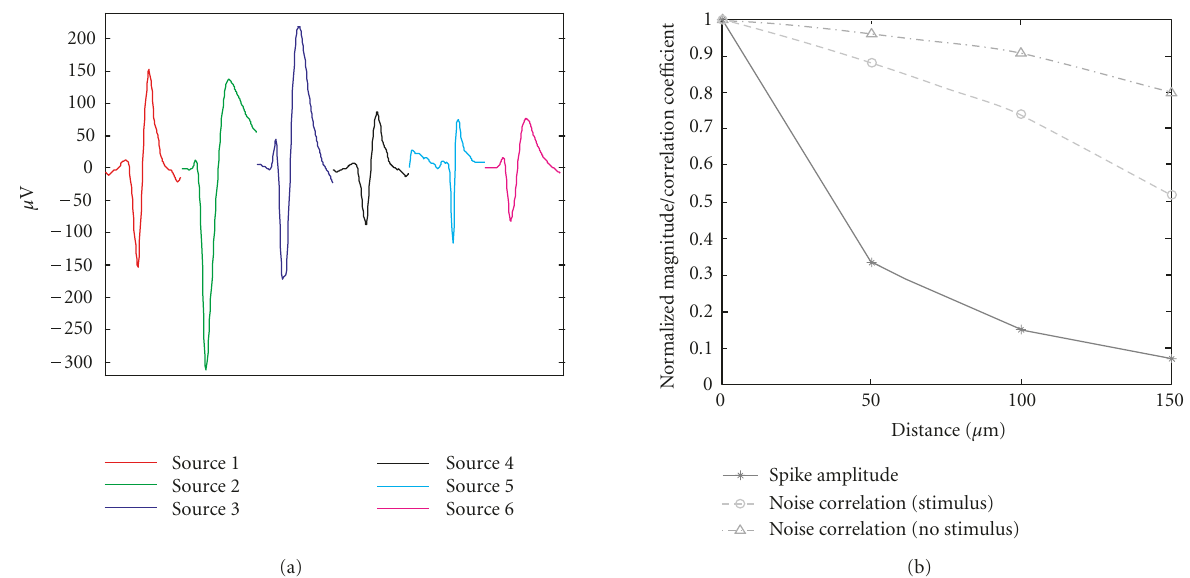
Figure 4: Temporal and spatial characteristics of the observed signal and noise processes. The left panel demonstrates six waveforms ex- tracted from recordings of six distinct neurons. Waveforms have been cleaned by proper time alignment and averaging across multiple realizations to display the templates shown.